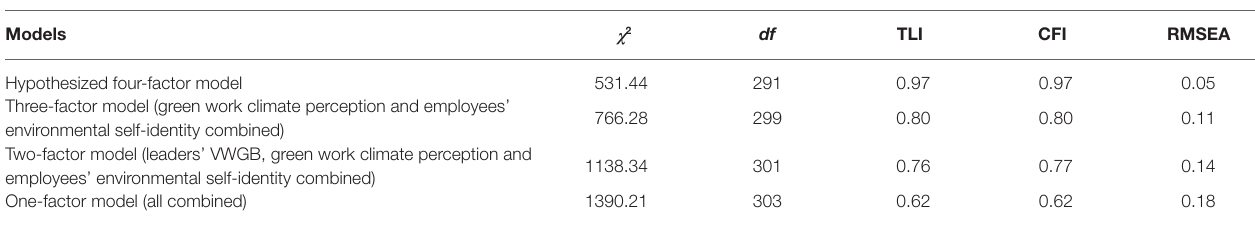
TABLE 1 | Results of CFA.